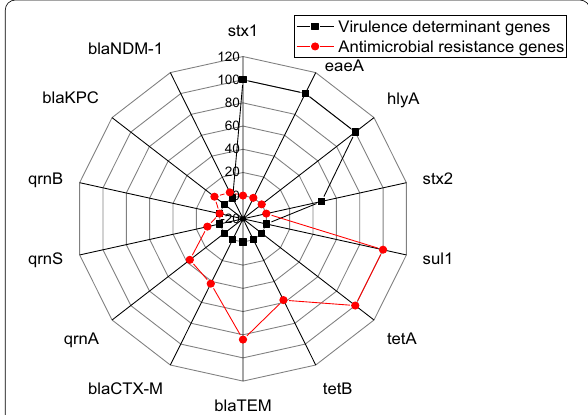
Fig. 3 The dissemination of virulence determinants and antimicrobial resistance genes between the retrieved E. coli isolates